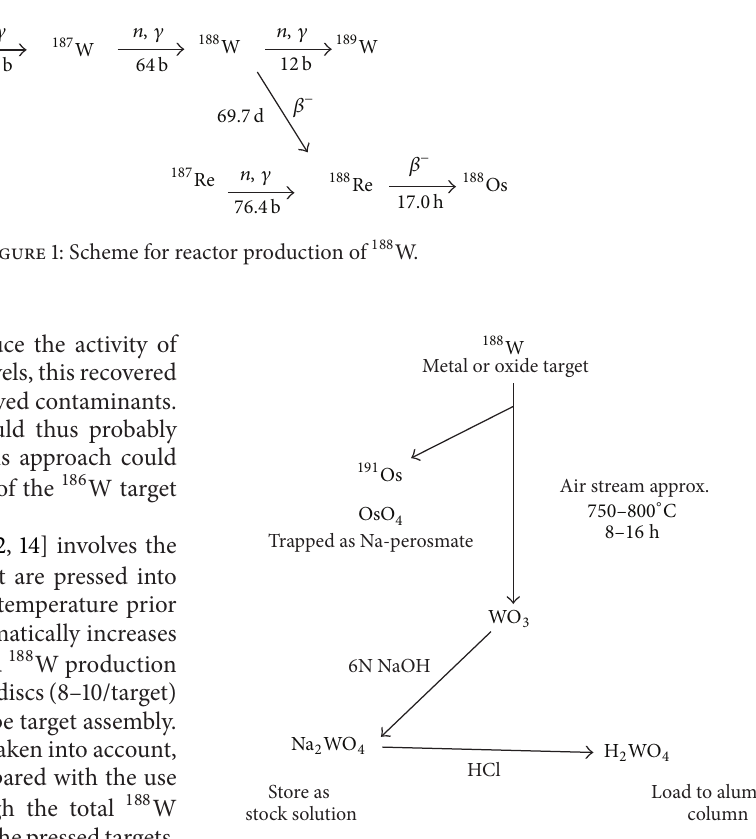
Figure 2: ORNL postirradiation processing scheme for pressed/ sintered enriched 186 W metal targets